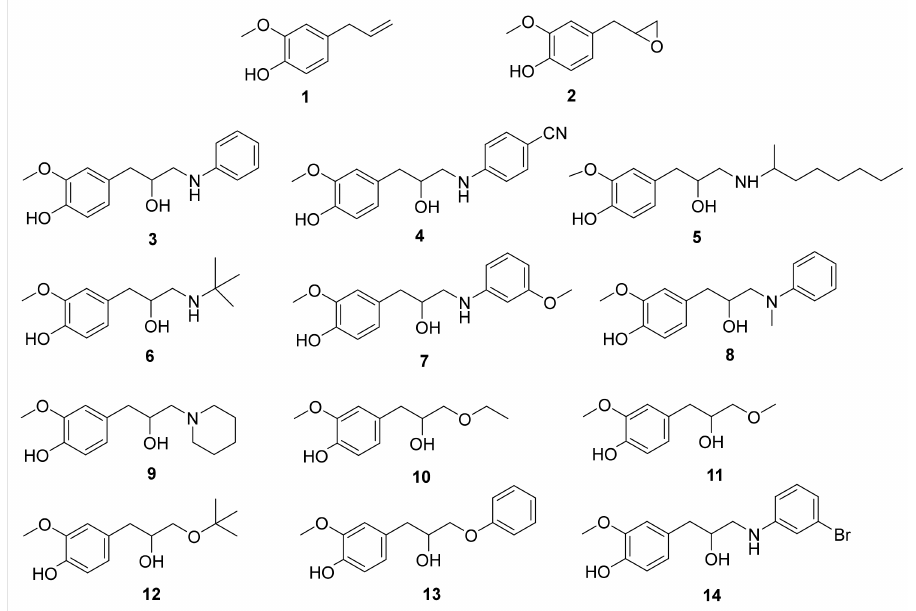
Figure 8. Chemical structures of eugenol 1 , epoxide 2 , β -amino alcohols ( 3 – 9 , 14 ) and β -alkoxy alcohols ( 10 – 13 ), obtained through different reactions between eugenol epoxide 2 and several amines or alcohols,